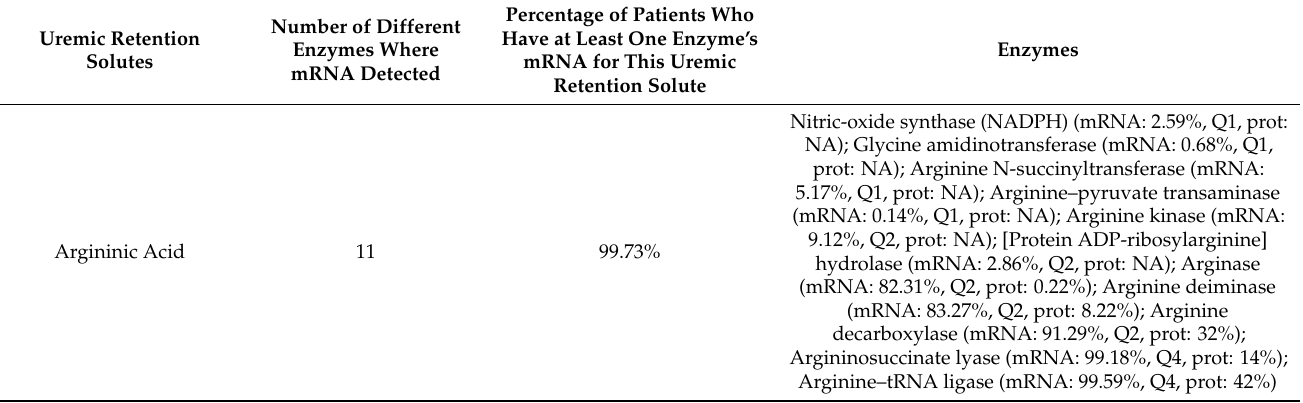
Table 3. Uremic retention solutes and their synthesizing enzymes’ mRNA abundance in HMP2. Presented uremic retention solutes had at least one enzyme’s mRNA represented in more than 90% of patients. The following information is given in parentheses for each enzyme: mRNA - percentage of patients who have mRNA for this enzyme; Q - quartile for this mRNA abundance; prot - percent of patients who have protein for this enzyme detected in proteome. The complete list is available in Supplementary Table